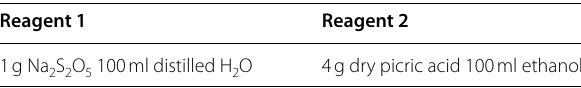
Table 2 Composition of LePera solutions Reagent 1 Reagent 2